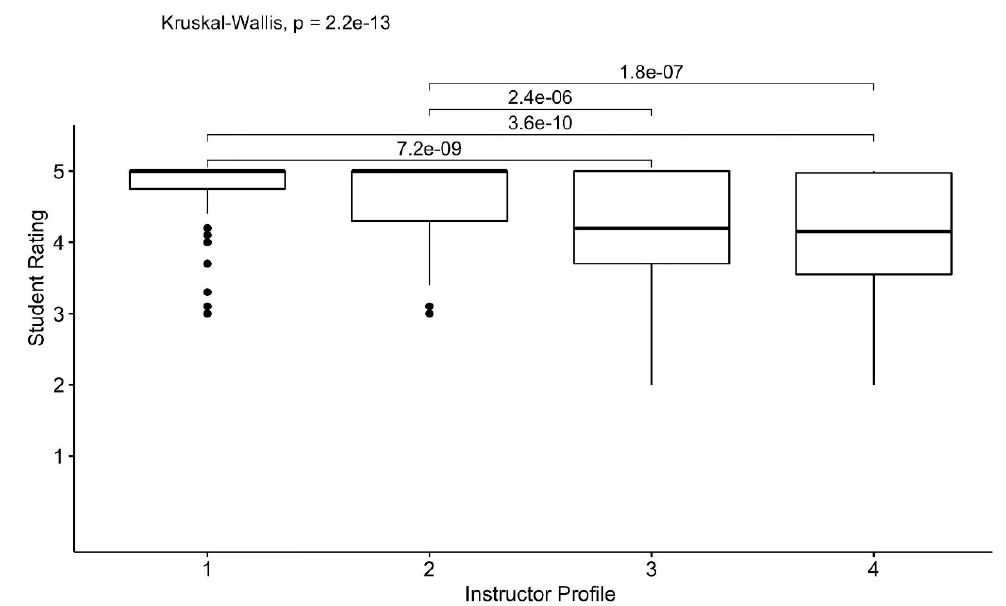
Figure 1. Content knowledge ratings according to instructor profile. Instructor 1 is a native speaker from Spain, Instructor 2 is a native speaker from Latin America, Instructor 3 is a Heritage Speaker of Spanish, and Instructor 4 is an L2 Spanish speaker.